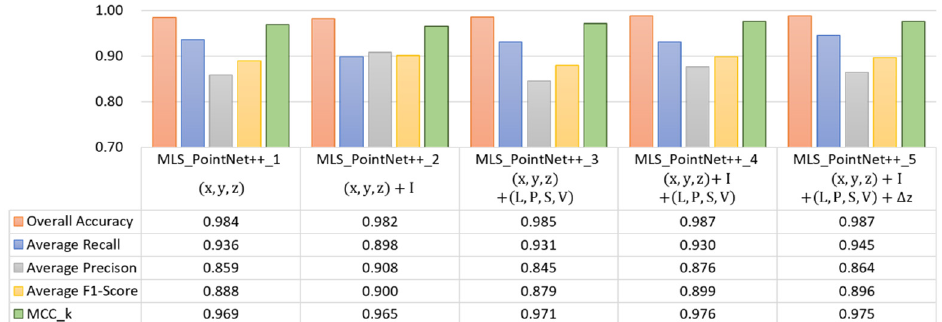
Figure 12. Comparison of classification results using PointNet++ with different handcrafted features on MLS point clouds.